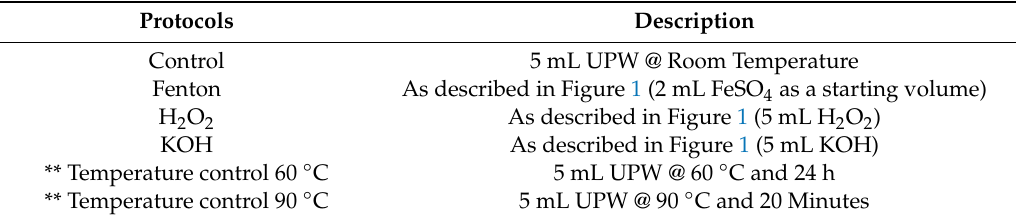
Table 2. Protocols that were investigated for their e ff ects on the polymers. Protocols